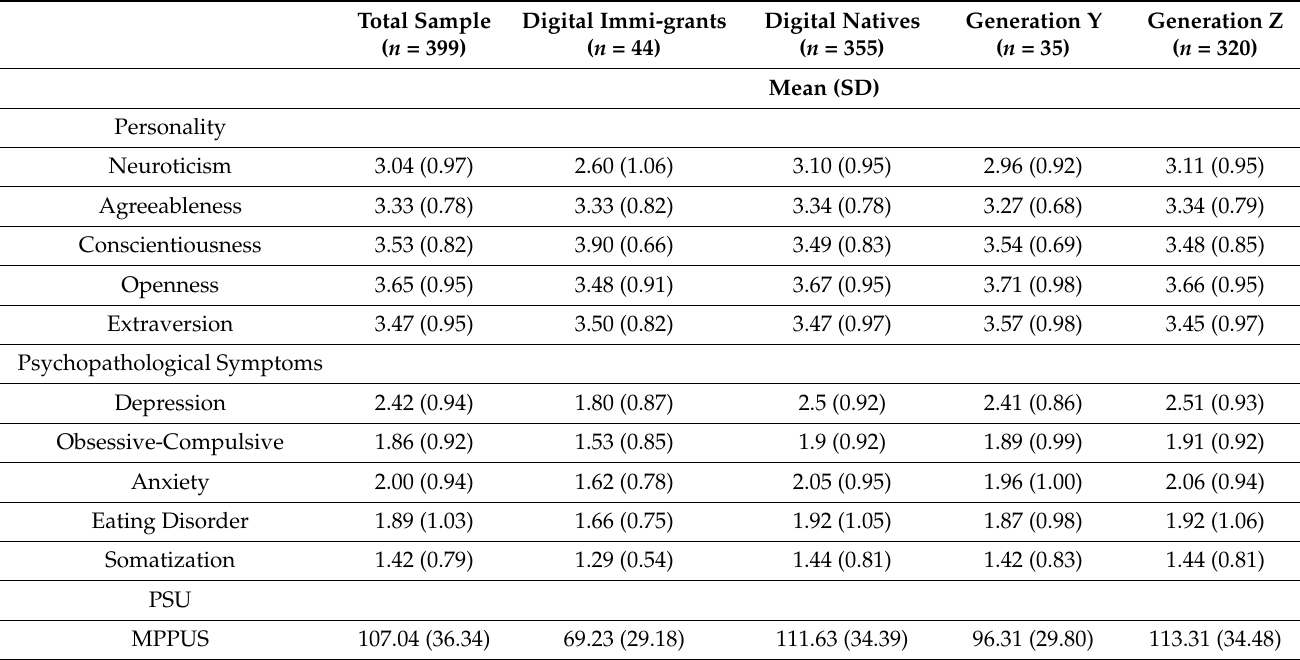
Table 2. Descriptive statistics for ISR, BFI-10, and MPPUS (total sample, digital immigrants, digital natives, Generation Y, and Generation